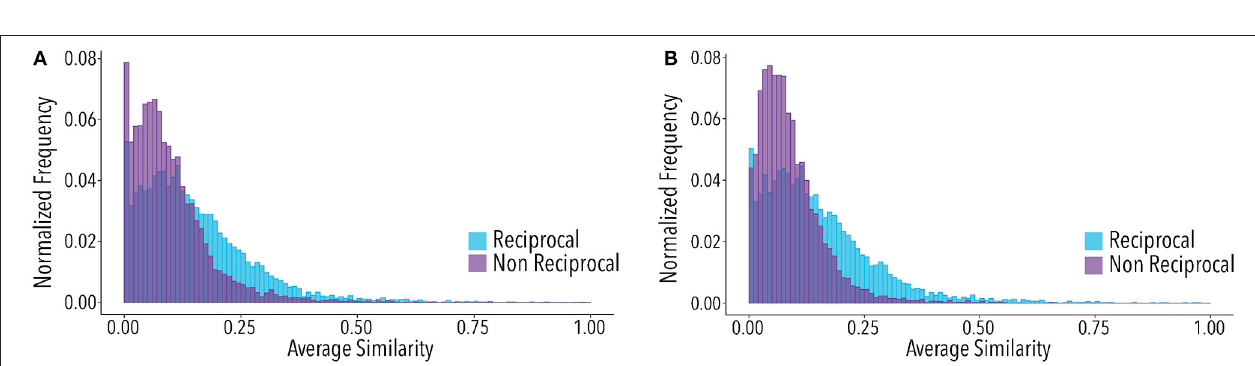
FIGURE 5 | Correlation between average similarity with followees and mentioned users. Each point corresponds to the average similarity between a central user and the users she follows and the average similarity between the central user and the users mentioned by her. The Pearson correlation between the two variables is 0.84.